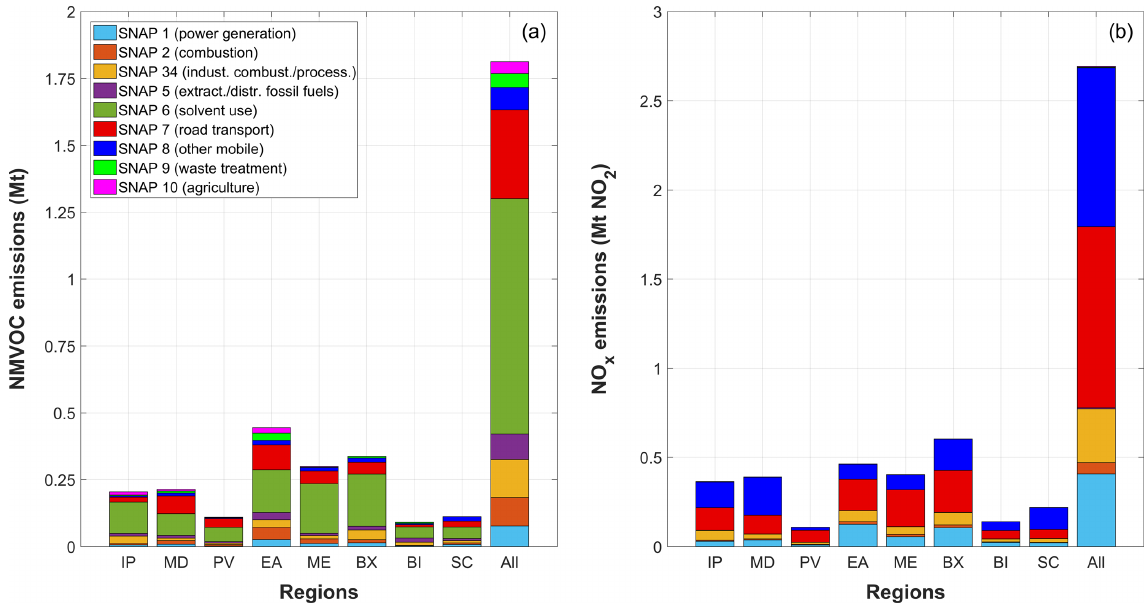
Figure 2. Total NMVOC (non-methane volatile organic compounds) (a) and NO x (b) emissions integrated over the summer (JJA) of 2010 per SNAP category for each region in Europe as well as for their sum. A detailed description of the SNAP source categories is given in Table S2. A definition of the regions is given in Fig.